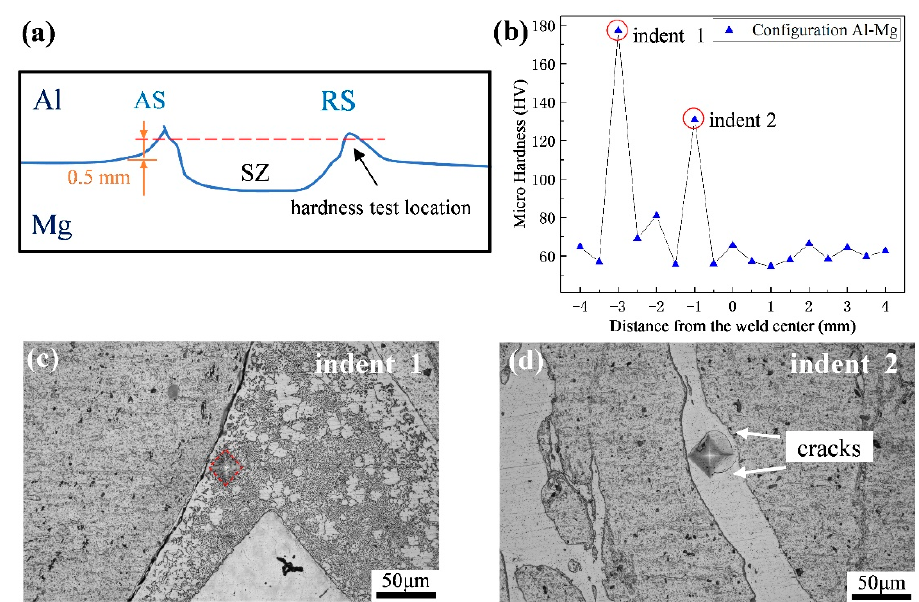
Figure 10. Results of microhardness tests of the joint welded in Configuration Al-Mg at 700 rpm: ( a ) schematic diagram of hardness test location; ( b ) microhardness profiles; ( c ) optical micrograph at indent 1; ( d ) optical micrograph at indent 2.